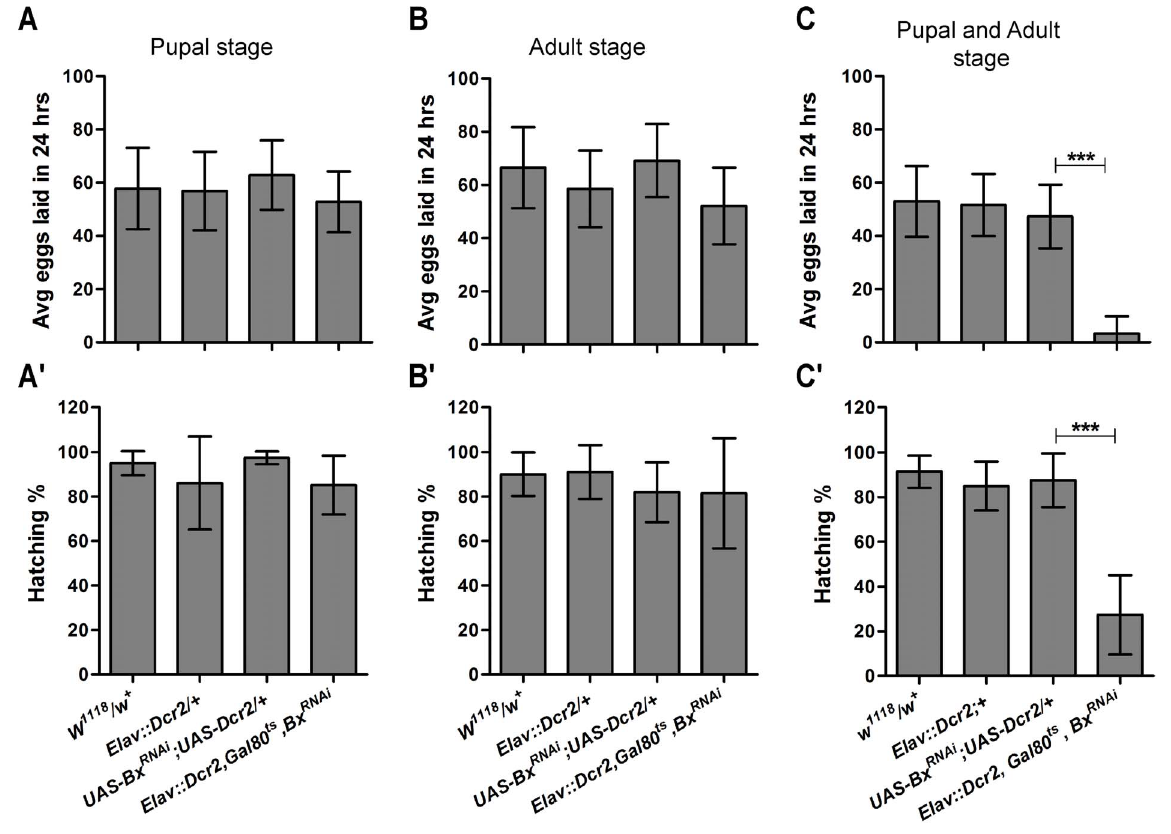
Figure 4. Bx function in the neurons is essential during both the pupal development and adult stage for efficient female reproduction. (A–B’) Knock down of Bx in the neurons during pupal stages (A, A’) or adult stage (B, B’) did not affect either fecundity (A, B) or fertility (A’, B’) of the females. (C, C’) Knock down of Bx in both the pupal and adult stages reduced fecundity (C) and fertility (C’) significantly (unpaired t-test, ***, p ,